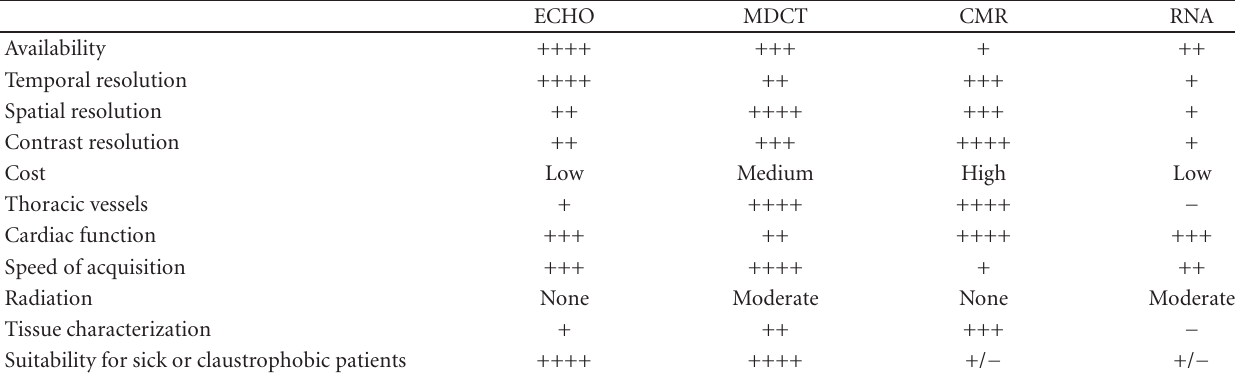
Table 1: Relative strengths and weaknesses of non-invasive imaging modalities.